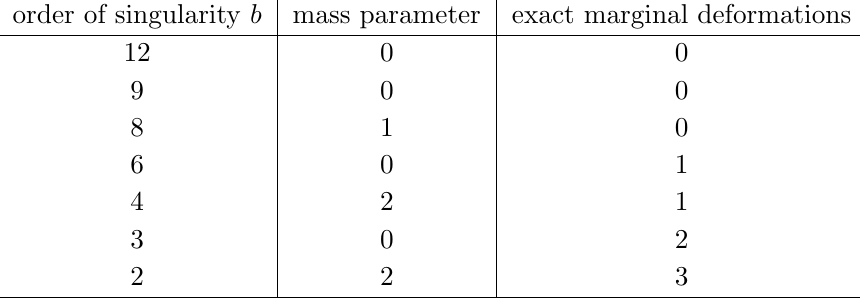
Table 4 . Summary of mass parameters and number of exact marginal deformations in E 6 .